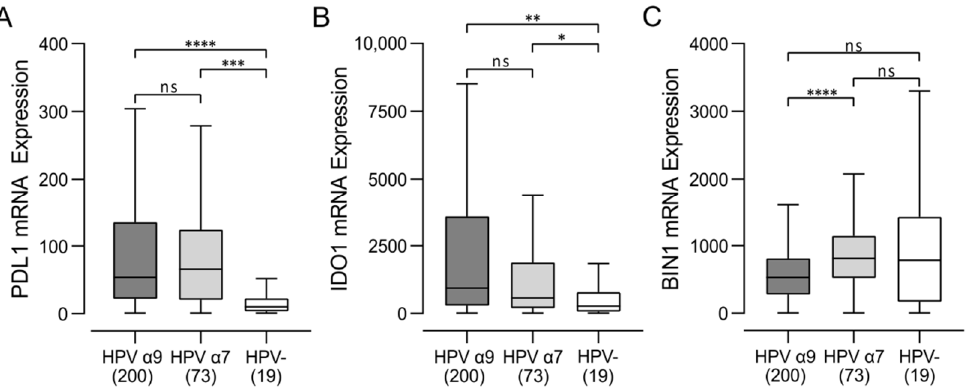
Figure 5. Transcript levels of tumor-derived interferon-responsive immunomodulatory genes in cervical cancer. Normalized RNA-seq data for genes associated with tumor cell mediated immunomodulation, including ( A ) PDL1 (CD274), ( B ) IDO1, and ( C ) its negative regulator BIN1, were compared between HPV-positive (HPV α 9 and HPV α 7) and HPV-negative (HPV-) cervical cancers. Numbers in brackets refer to the number of samples included in each analysis. **** p ≤ 0.0001, *** p ≤ 0.001, ** p ≤ 0.01, * p ≤ 0.05, ns (not significant).